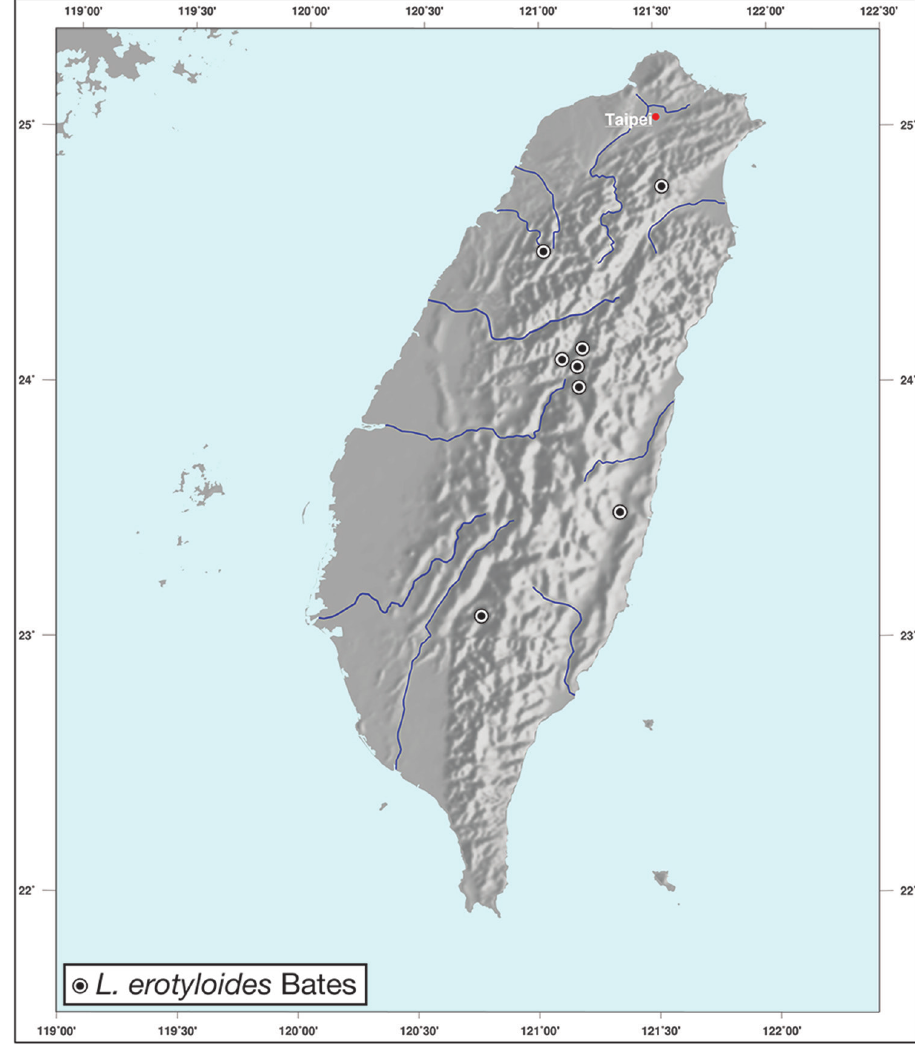
Figure 89. Map showing known localities for species of the genus Lioptera Chaudoir, in Taiwan.